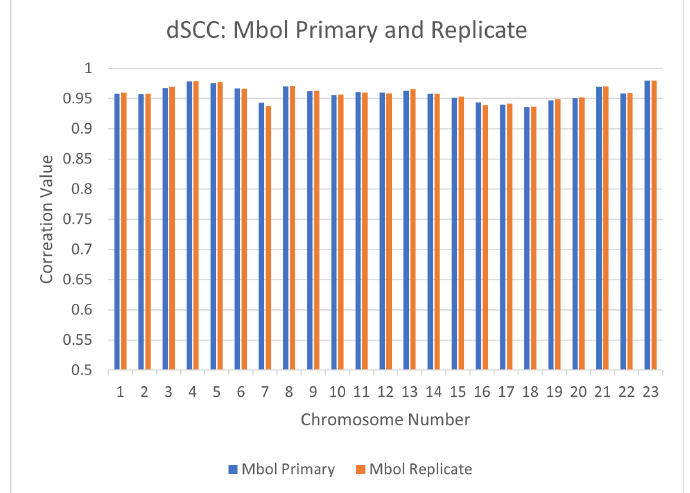
Figure 14. Comparison of the output dSCC for CBCR utilizing the primary and replicate mappings with the Mbol restriction enzyme at 1mb resolution.